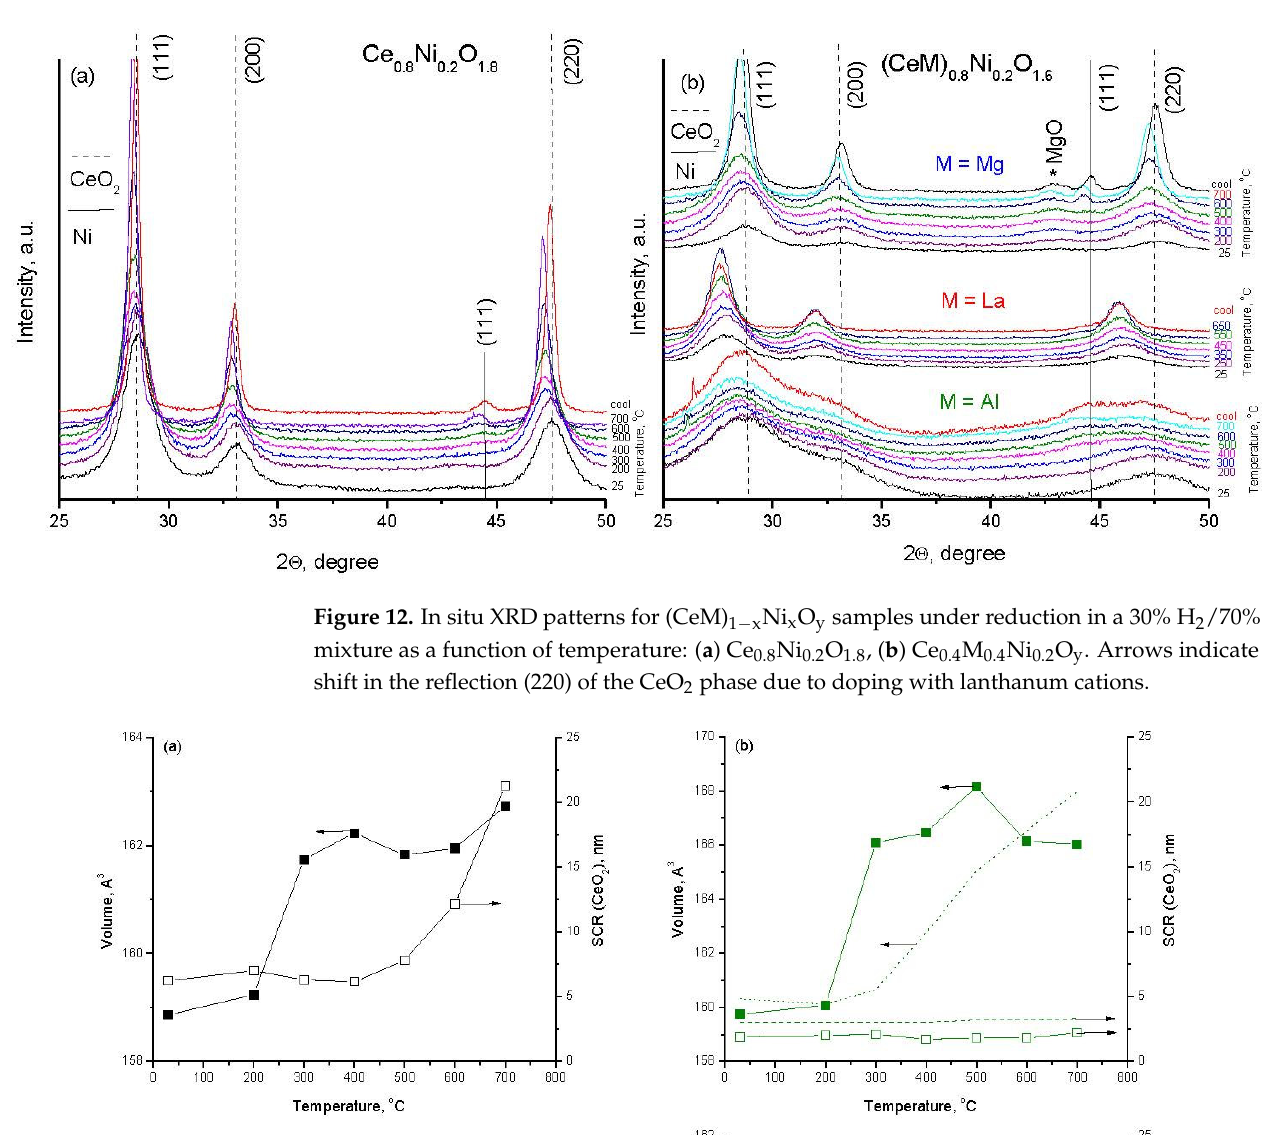
Figure 11. The effect of Ni molar fraction ( a ) and M/Ce molar ratio ( b ) on the total H 2 consumption